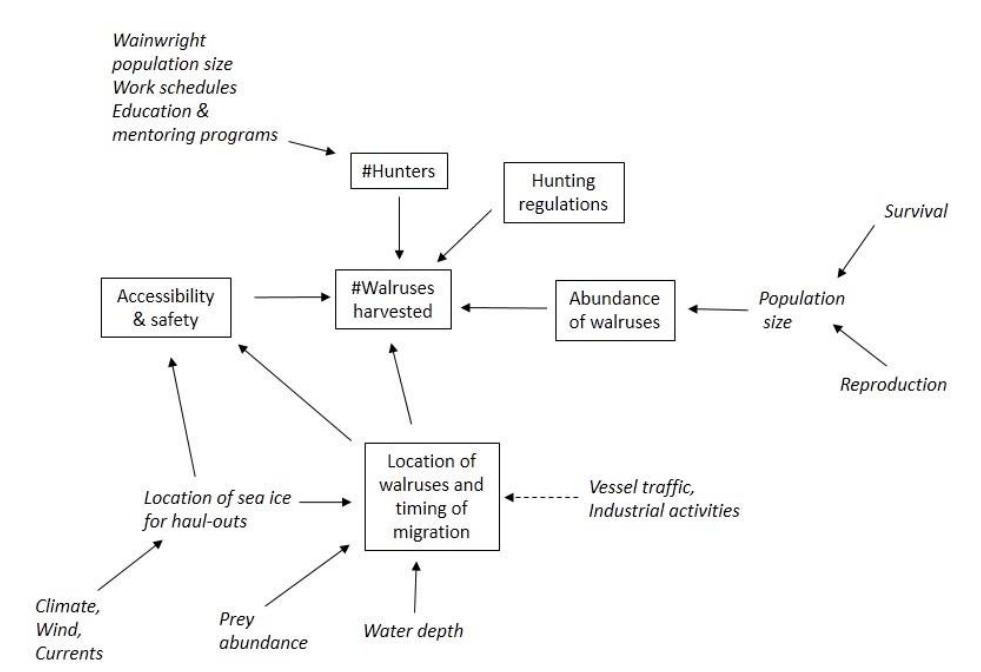
Figure A1.3. Model of walrus subsistence system in Wainwright, Alaska